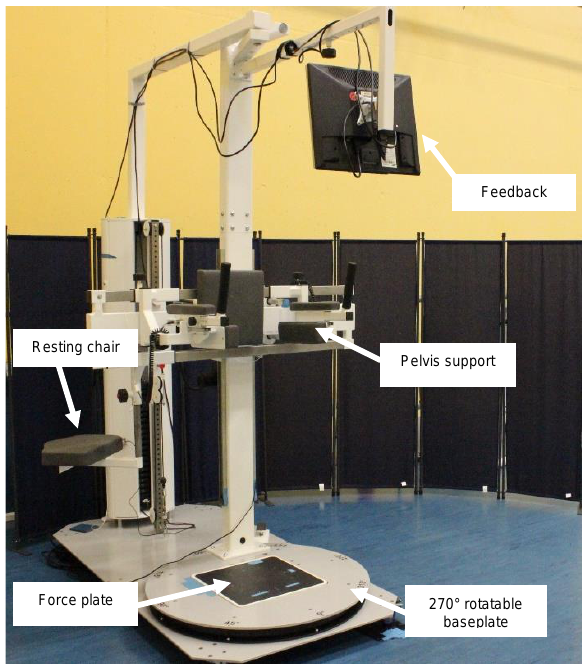
Figure 1: The sensor-based diagnostic device in the overall display.